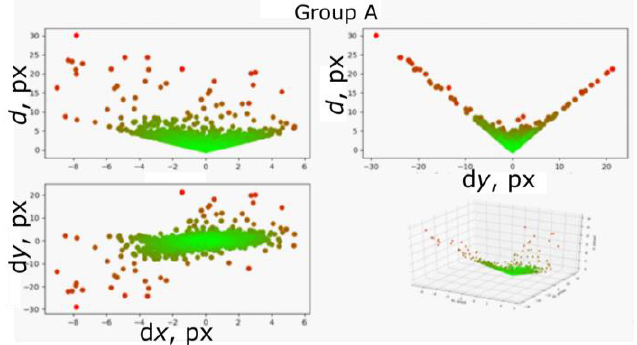
Fig. 6. Video 1, group A observations.